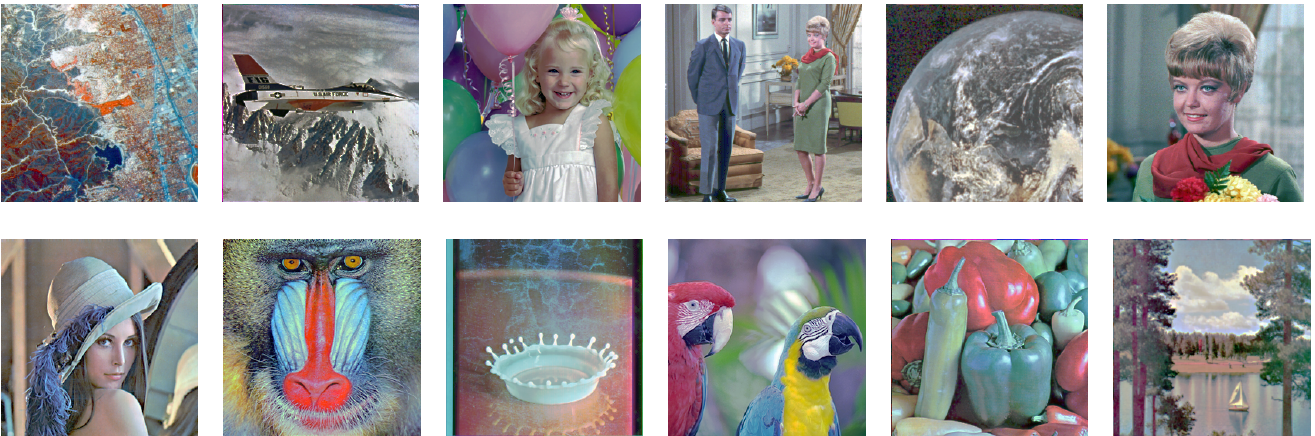
Figure 24. Results of the separable histogram specification with Nikolova and Steidl’s exact histogram specification algorithm.